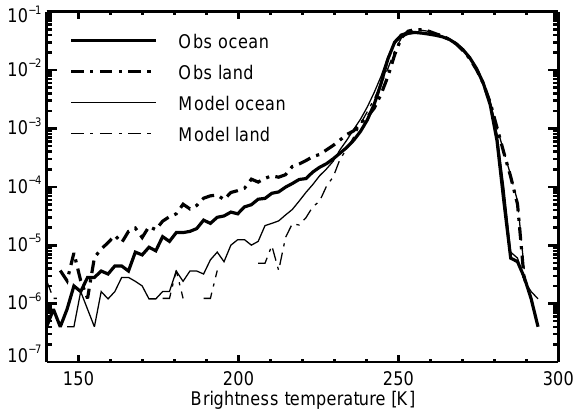
Figure 12. Measures of fit in the fine search over land, each ranked from best to worst and normalised so that the worst equals 1. Figure 13. Normalised histograms of 183 ± 1GHz brightness tem- peratures in June 2012 over land and ocean. Model results are gener- ated using the sector snowflake experiment from the coarse